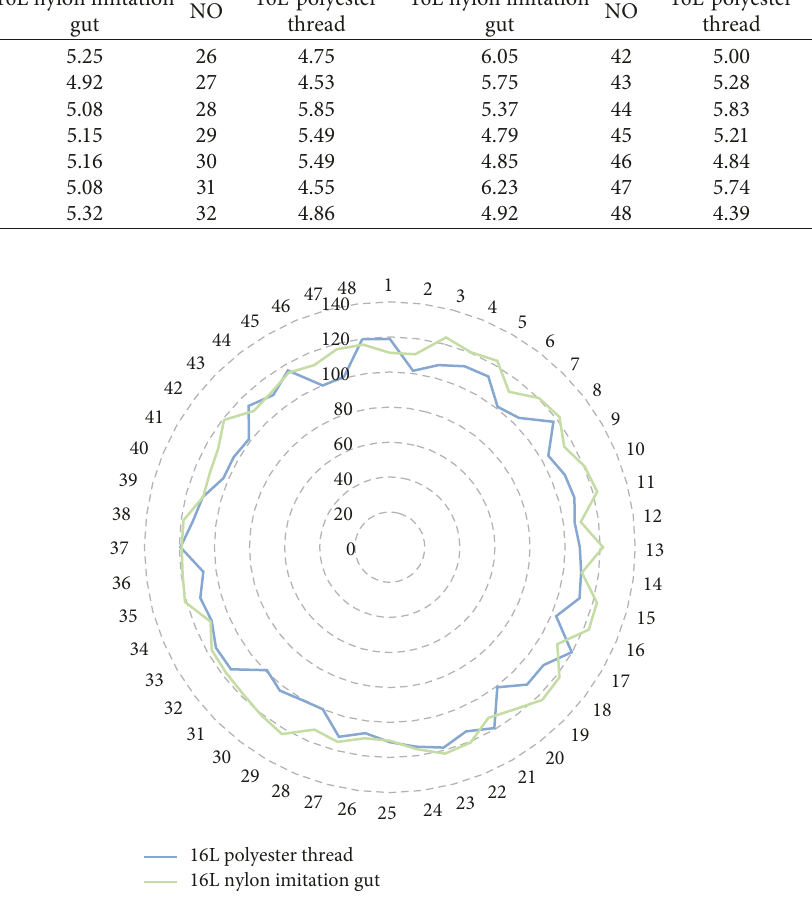
Figure 6: Statistical diagram of racket impact vibration frequencies of different material groups.